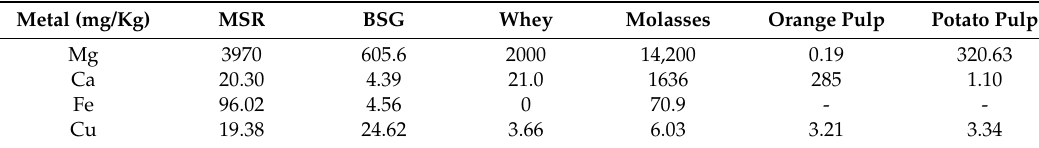
Table 2. Metal elements contained in the used